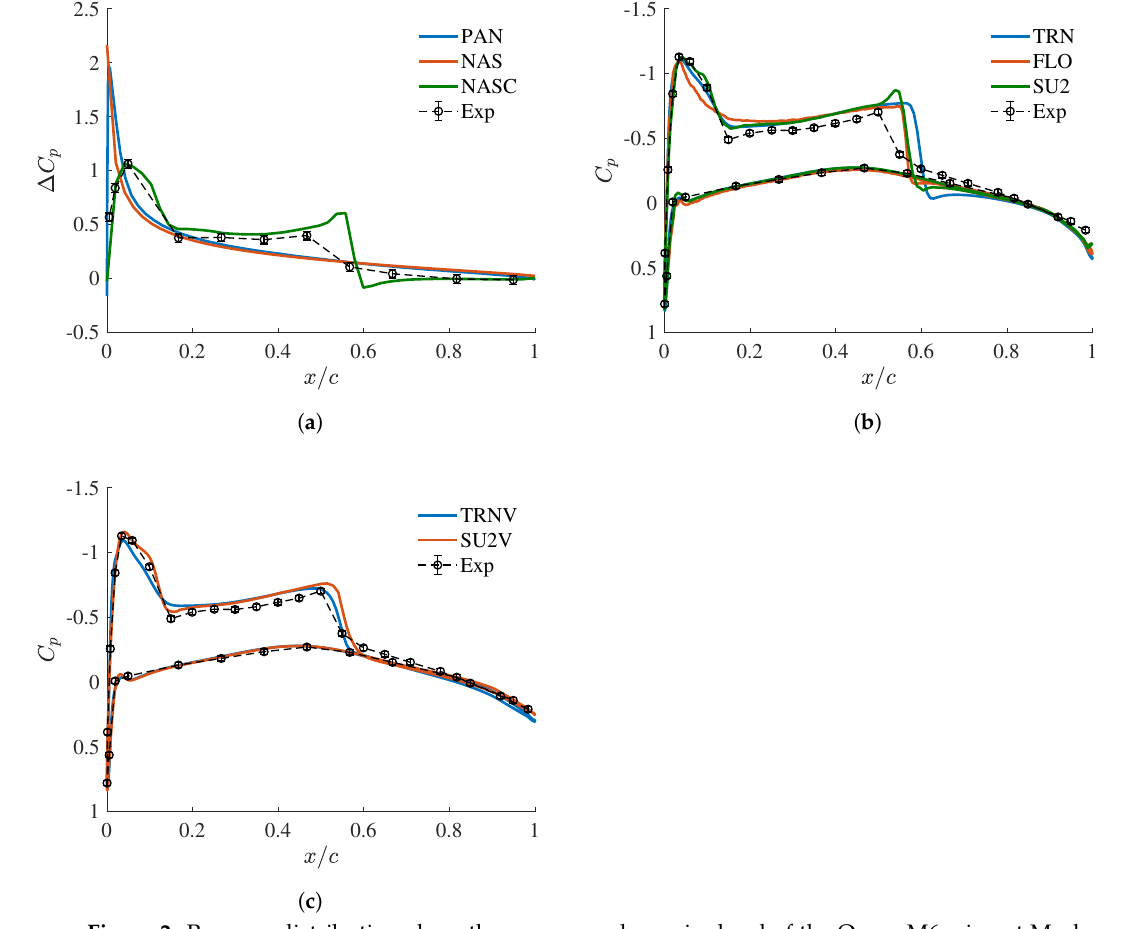
Figure 2. Pressure distribution along the mean aerodynamic chord of the Onera M6 wing at Mach 0.839 and angle of attack 3.06 ◦ obtained from different levels of fidelity and compared to experimental data [26]: ( a ) linear models; ( b ) nonlinear inviscid models; and ( c ) viscous